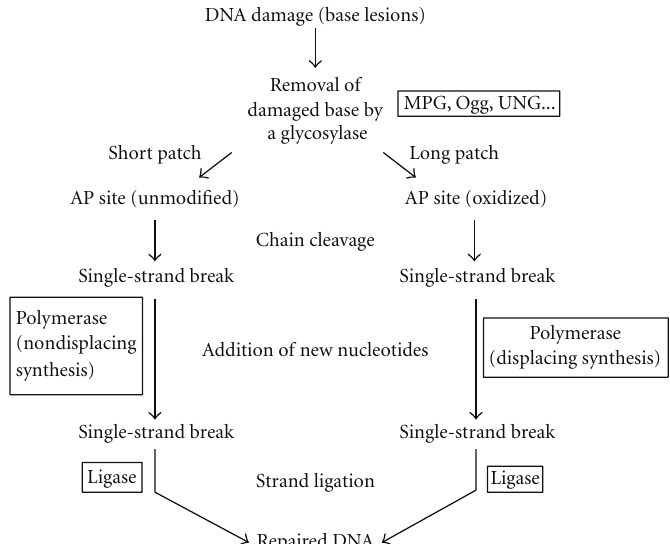
Figure 1: The schematic diagram of base excision repair (BER) pathway for DNA repair throughout the cell cycle. BER is important for removing damaged bases. BER is initiated by DNA glycosylases (e.g., MPG), which recognize and remove specific damaged or inappropriate bases, forming AP sites. These are then cleaved by an AP endonuclease. The resulting single-strand break can then be processed by either short-patch or long-patch